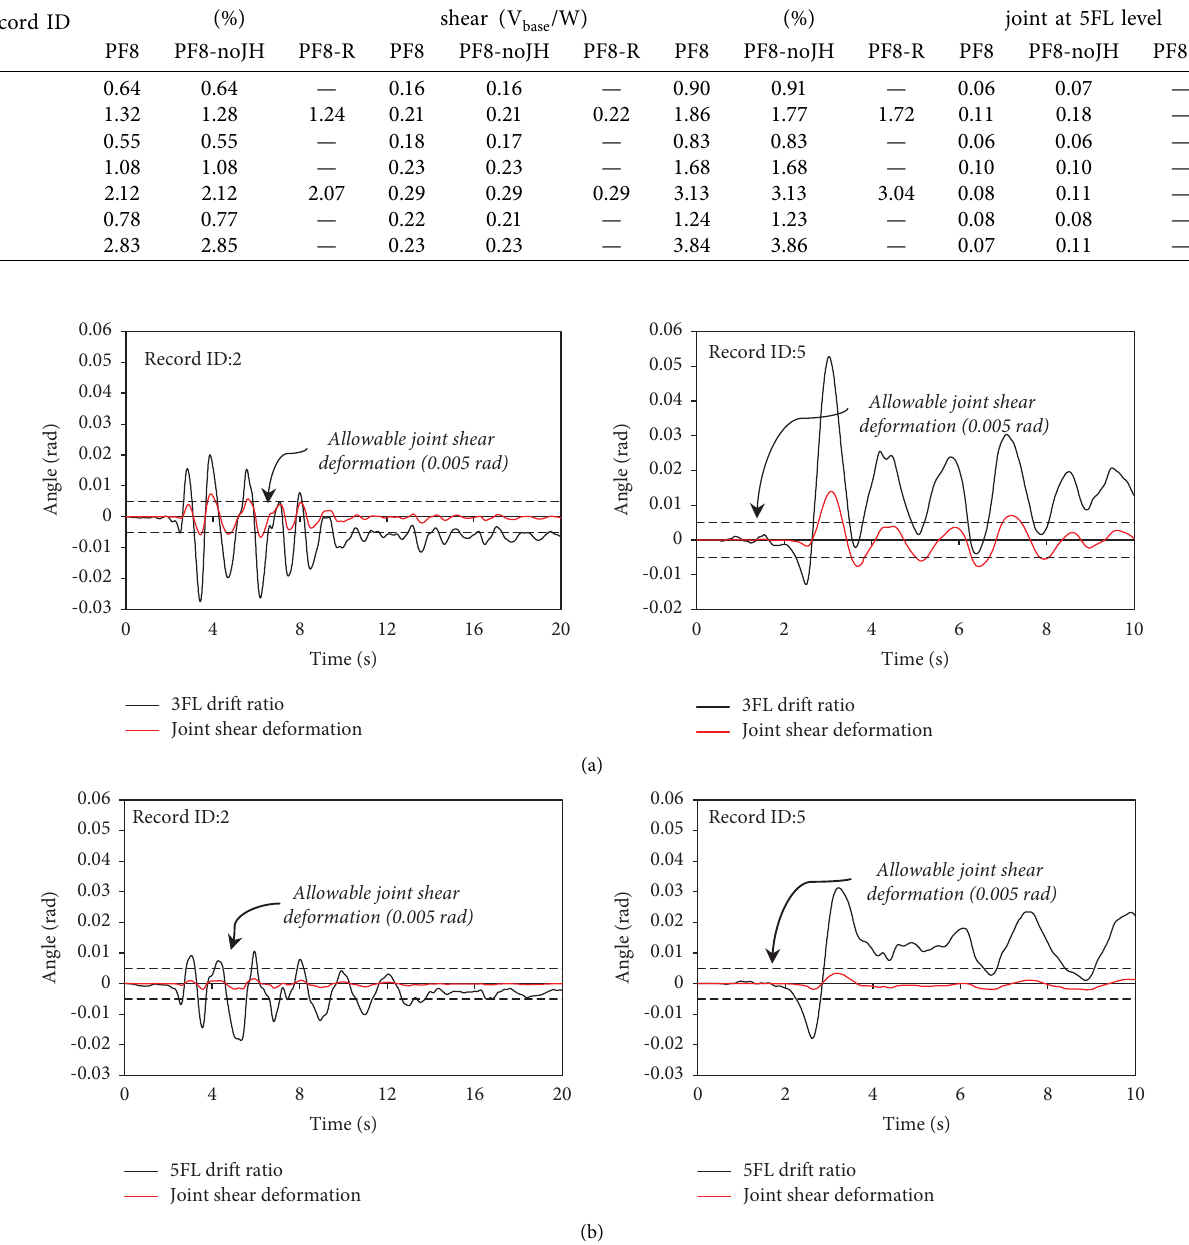
Figure 14: Joint shear deformation history. (a) Frame PF4: interior joint at 3FL. (b) Frame PF8: interior joint at